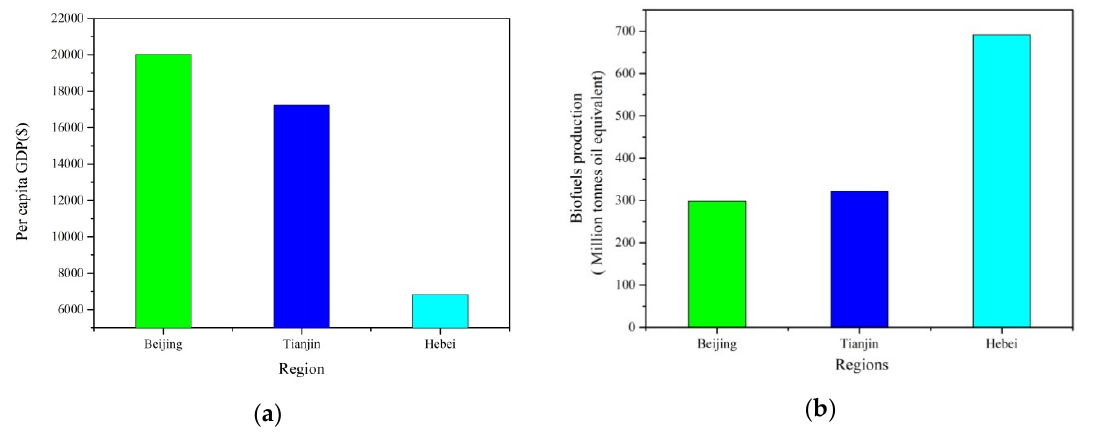
Figure A1. Biofuel production and per capita GDP of the Beijing, Tianjin, and Hebei regions. ( a ) The per capita GDP of the Beijing, Tianjin, and Hebei regions (source: https://data.worldbank.org.cn/); ( b ) Biofuel production of the Beijing, Tianjin, and Hebei regions by analogy based on the same level of economic development in the world (source: http://data.stats.gov.cn/ and [9]).